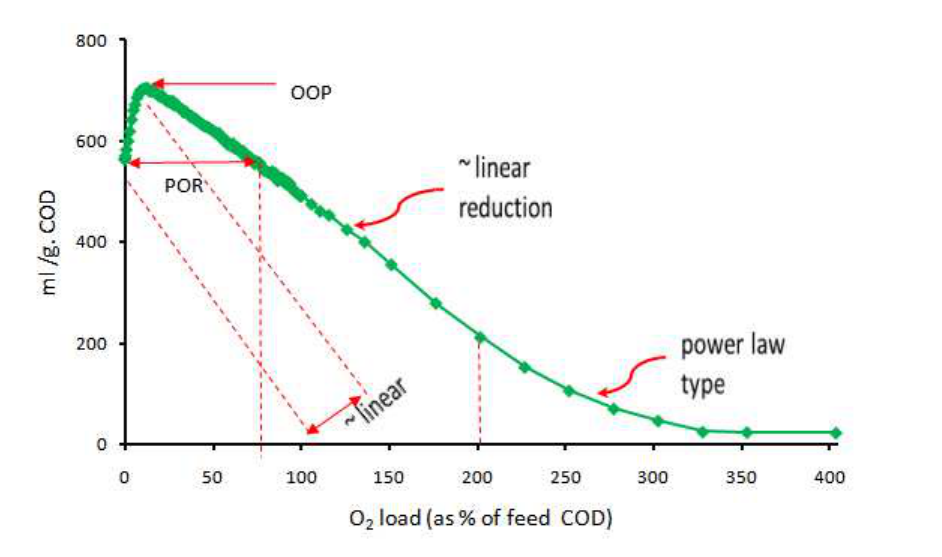
Figure 5: Simulated CH 4 yield variation with oxygenation level, for the BT 1 conditions (OOP = optimum oxygenation point ; POR = positive oxygenation